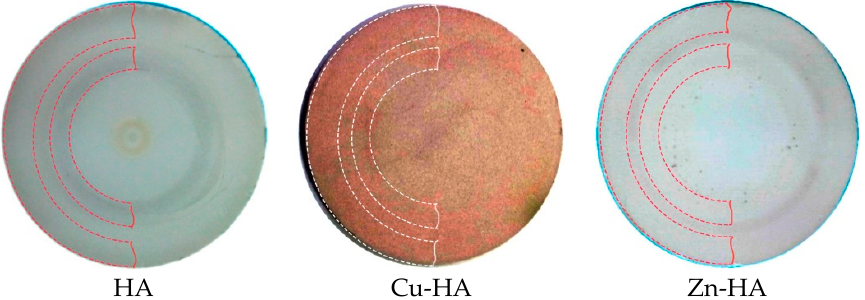
Figure 5. Digital photos of targets with a visible zone of erosion after multiple sputtering runs. Two areas of target erosion are highlighted in dotted lines for each photo.